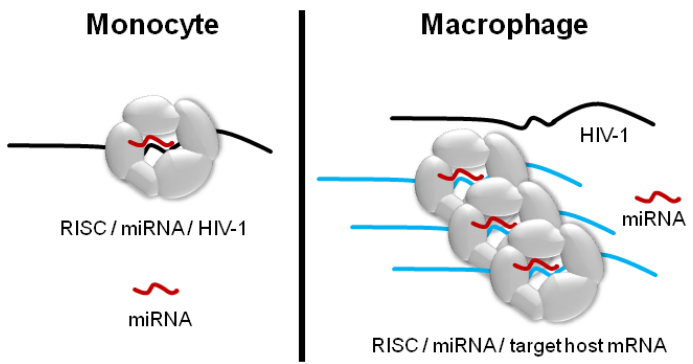
Figure 2. miRNA-mediated regulation depends on factors in addition to miRNA copy number. A hypothetical host miRNA (red) and the RISC machinery binding to the HIV-1 transcript in a monocyte but not in a macrophage. With differentiation of the monocyte, the miRNA is upregulated two-fold, but a host target transcript (blue) with a high-affinity target site for the miRNA is also produced, acting as a “sponge” for most of the miRNA copies. Thus, alongside miRNA copy number, the copy numbers and binding affinities of both the original target of interest and all possible alternative targets are determinants of the extent of miRNA-mediated regulation. RISC component availability, other targeting miRNAs, RNA binding cofactors, and subcellular localization of interaction partners may also affect miRNA-target relations (not